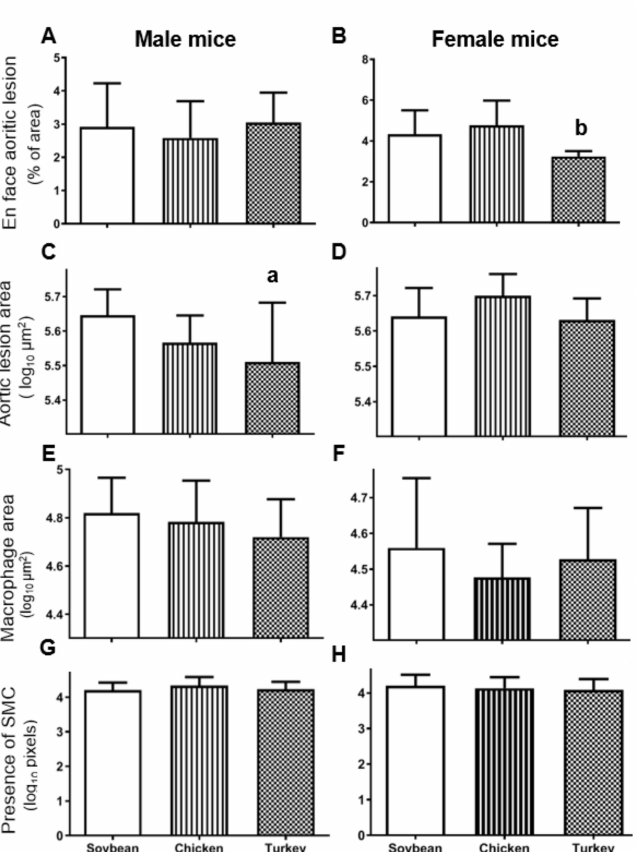
Figure 2. Atherosclerosis lesions in APOE KO mice consuming the different diets. En face aortic analyses of whole aortas expressed as percentage of total area occupied by lesions ( A , B , males and females, respectively). Cross sectional lesion areas at the aortic root analyzed by oil red staining and expressed as log 10 µ m 2 ( C , D ). Lesion areas covered by macrophages according to CD68 im- munostaining expressed as log 10 µ m 2 ( E , F ). Presence of smooth muscle cells immunostaining for α -actin expressed as arbitrary pixel areas ( G , H ). The results are shown as means and SD. Statistical analyses were carried out by ANOVA followed by Bonferroni post-hoc test. a , p < 0.05 vs. soybean and b , p < 0.05 vs. chicken.